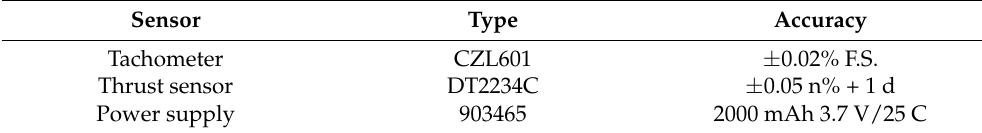
Table 1. Sensors.